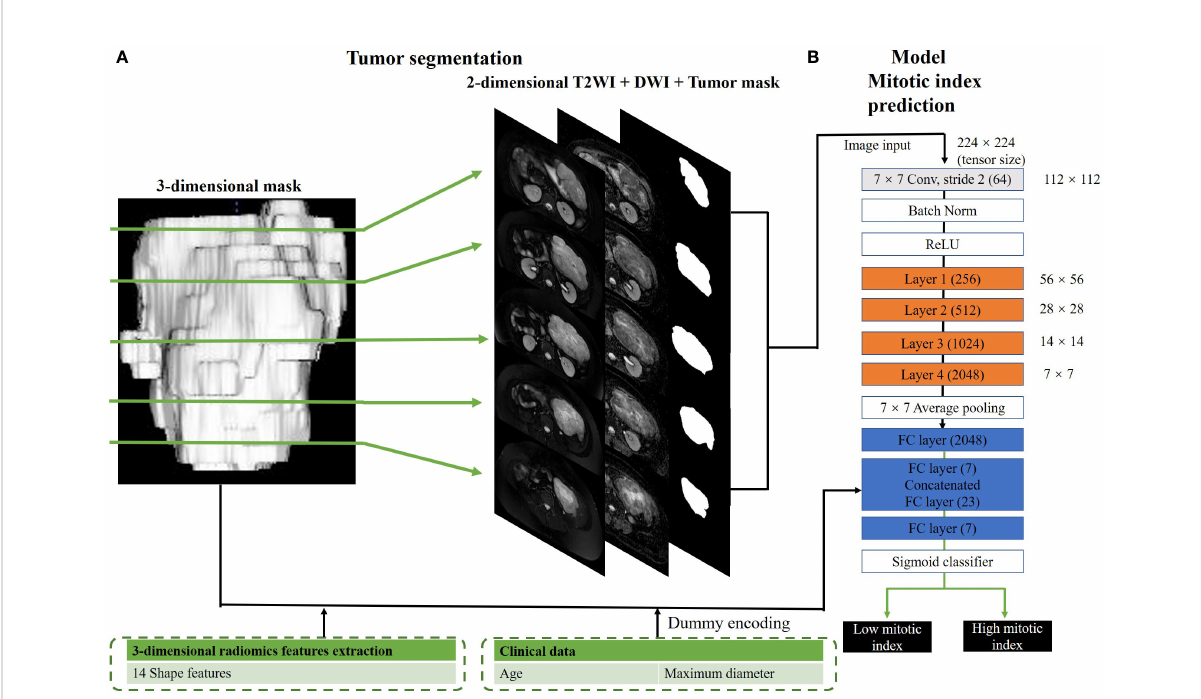
FIGURE 2 Hybrid model for mitotic index prediction. (A) shows the process of 3-dimensional and 2-dimensional image segmentation. We convert a three- dimensional mask to several two-dimensional masks. (B) shows the structure of hybrid mitotic index prediction model. In this model, layers 1 – 4 consisted of three, four, six, and three residual blocks, with each block containing 3 × 3 convolution once and 1 × 1 convolution